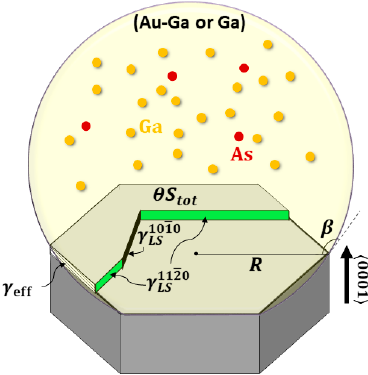
Figure 1. Schematic representation of fractional ML in a WZ GaAs NW, showing the model parameters.